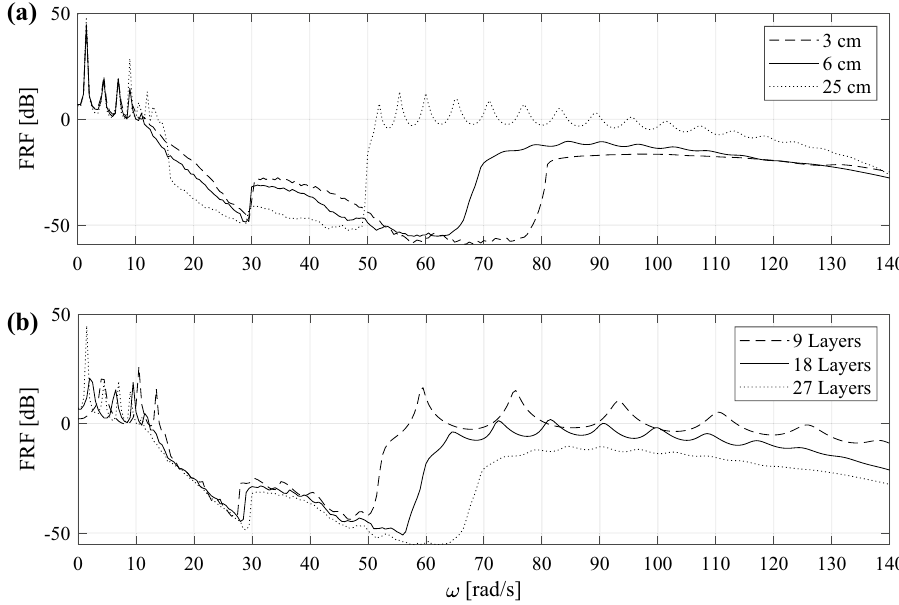
Figure 13. Numerical FRFs of a periodic finite lattice: ( a ) FRF for several input amplitudes A 0 for 27 layers; ( b ) FRF for several layers for A 0 = 6